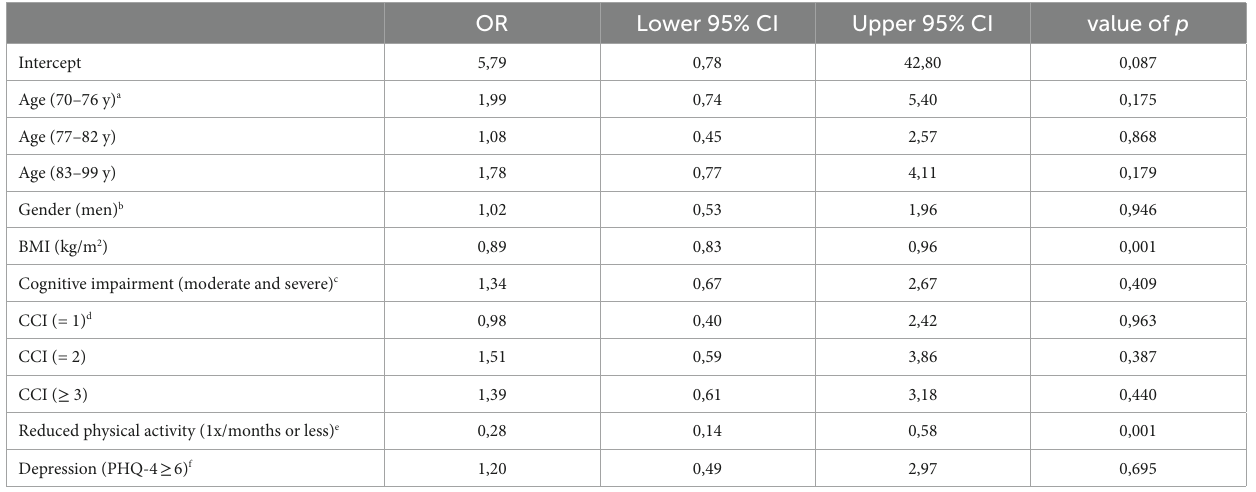
TABLE 2 Binary logistic regression model for malnutrition among ED patients with hip fracture.